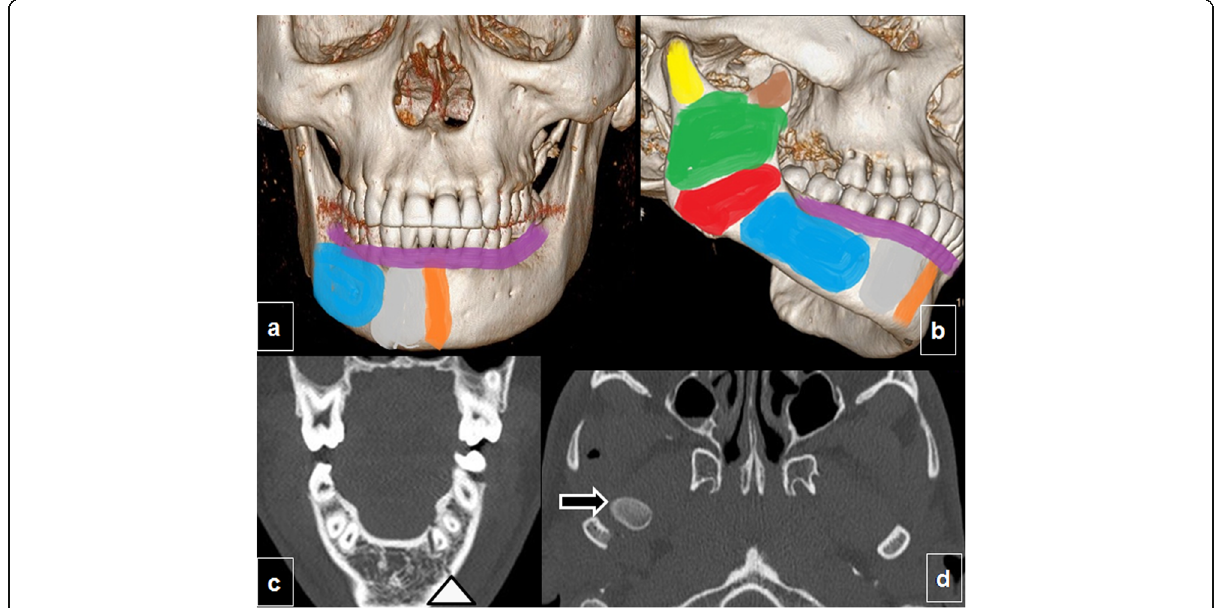
Fig. 12 Fractures of the mandible. Anatomy ( a , b ): three-dimensional CT image with color overlays indicating the parts of the mandible in coronal and lateral oblique orientations: the alveolar process (purple), symphysis (orange), parasymphyseal region (gray), body (blue), angle (red), ramus (green), coronoid process (brown), and condyle (yellow). c , d Bifocal mandibular fracture. c Coronal and ( d ) axial unenhanced CT of the mandible shows the classical pattern of bifocal mandibular fractures, affecting the body of the mandible on one side (arrowhead in c ) and the contralateral condyle with accompanying luxation (arrow in d